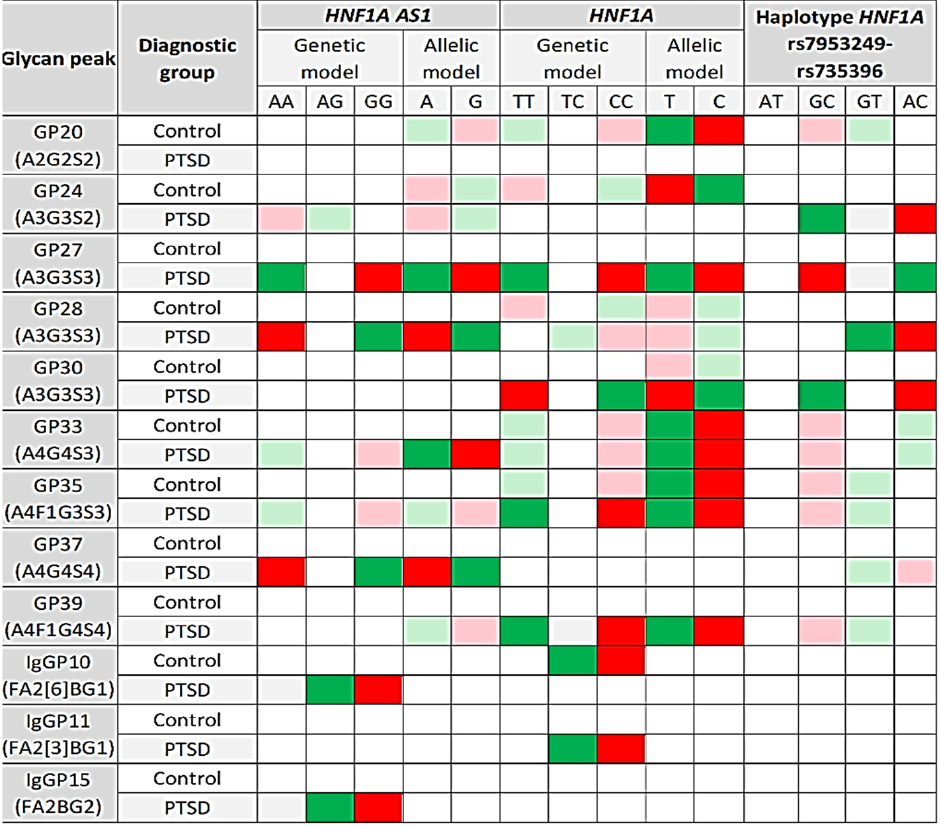
Figure 3. Summary of the significant ( p < 0.010) and nominally significant ( p < 0.050) changes in the N-glycan peaks associated with the HNF1A-AS1 rs7953249 and HNF1A rs735396 polymorphisms and their haplotype block in PTSD and control subjects. Red cells represent significantly (intense red) or nominally significantly (light red) lower abundance of N-glycan structures in some genotypes, alleles or haplotypes. Green cells represent significantly (intense green), or nominally significantly (light green) higher abundance of N-glycan structures in some genotypes, alleles or haplotypes.